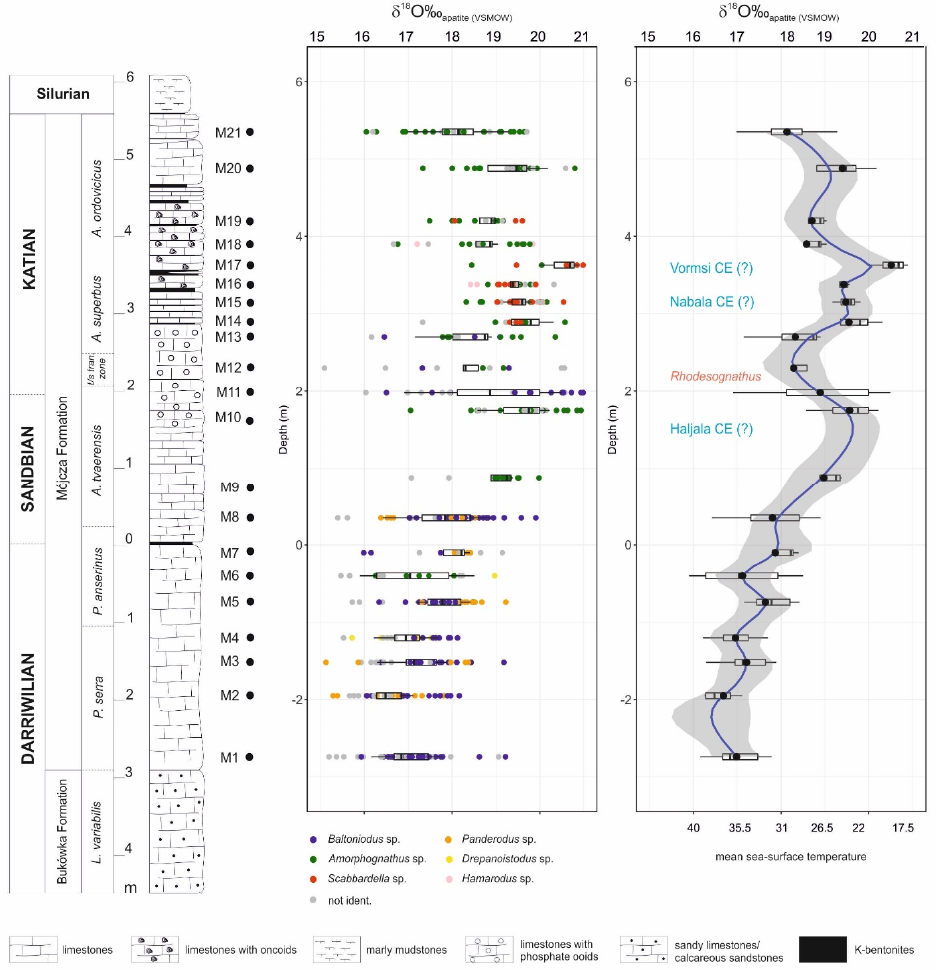
Figure 3. Oxygen isotope values from the late Middle-Late Ordovician conodonts of the M ó jcza section and mean δ 18 O apatite values for each studied sample on the right (conodont zones after Dzik [44,45]). Boxplot rectangles represent data for each sample with a range between the 25th and 75th quantiles. The arithmetic mean for all measurements obtained for the sample is represented by the black dot. Whiskers indicate maximum and minimum values within the 1.5 interquartile data range. The resultant blue curve-running three-point means calculated within the R-studio Environment, using the Local Polynomial Regression Fitting (LPRF) method, with a span of 0.2. The grey interval shows a confidence interval (of 95%). The sea-surface temperature was calculated using an equation from L é cuyer et al. [50], T [ ◦ C] = 117.4 ( ± 9.5) − 4.5 ( ± 0.43) ( δ 18 O apatite − δ 18 O seawater